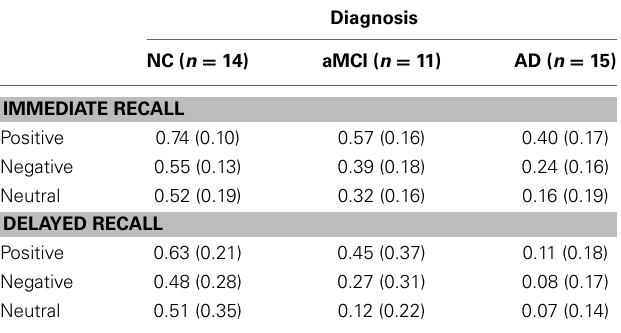
Table 4 | Results of linear regression analyses where gray matter volume in left and right amygdalae and hippocampi predicted immediate and delayed recall performance for positive and negative